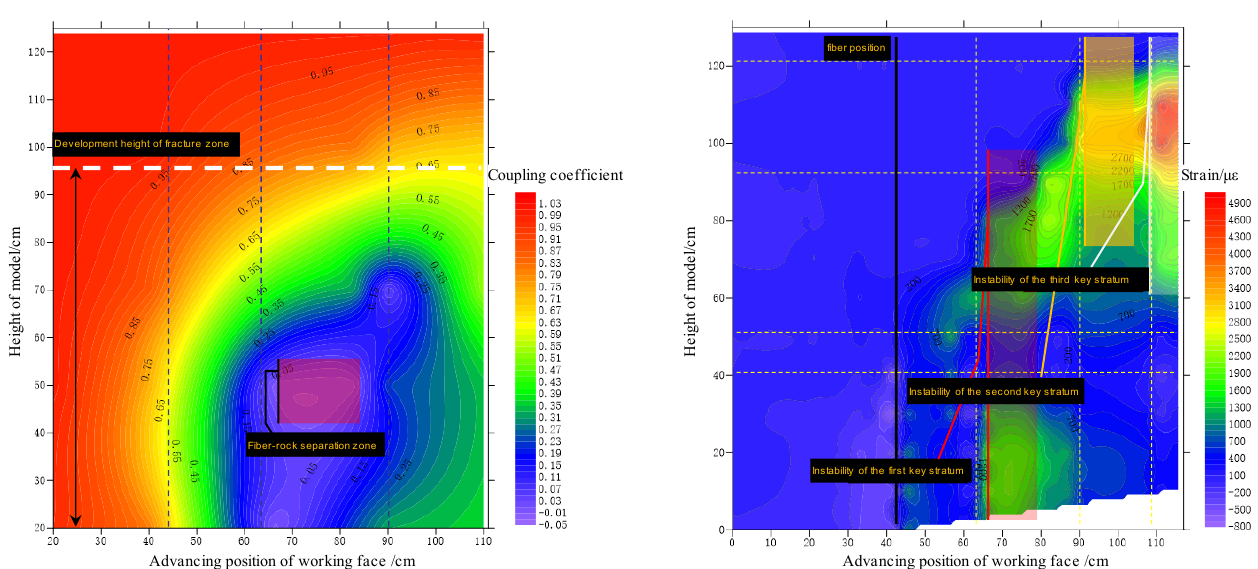
Figure 12. Spatiotemporal evolution of fiber–rock coupling coefficient with stope variation.